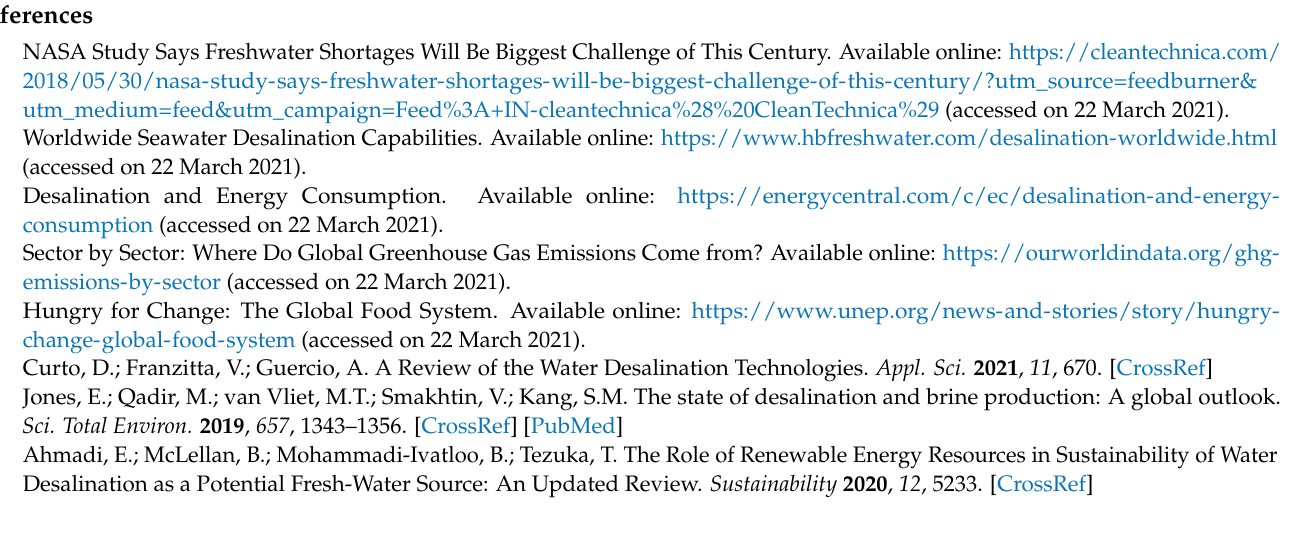
Figure A2. Battery storage costs from NREL and extrapolated costs for 8 and 16 h operation of the battery energy storage system (BESS) [68].